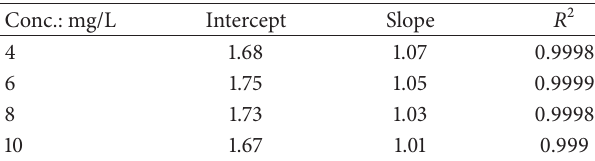
Table 5: Pseudo-second-order kinetics data for adsorption of MB C. polygonoides